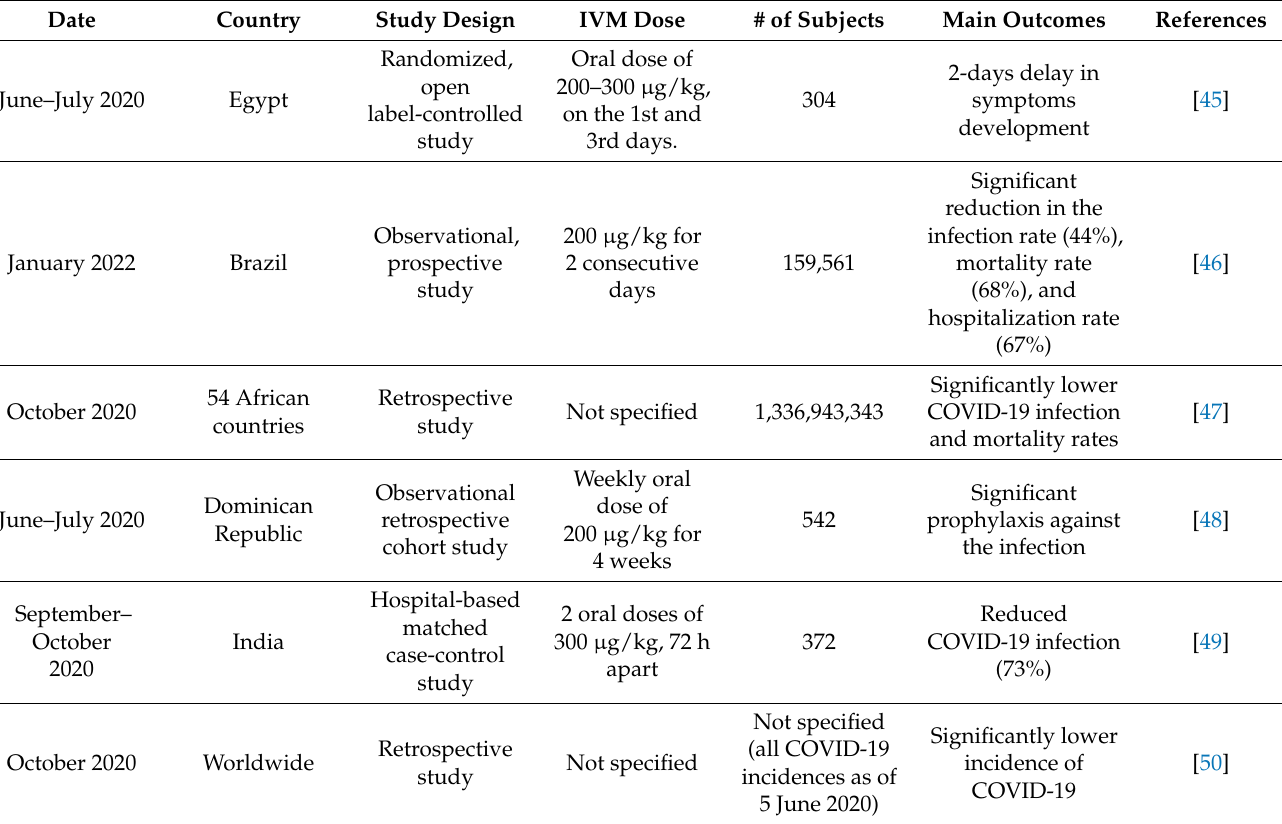
Table 2. Summary of the reviewed studies on the potential of IVM in the prophylaxis against